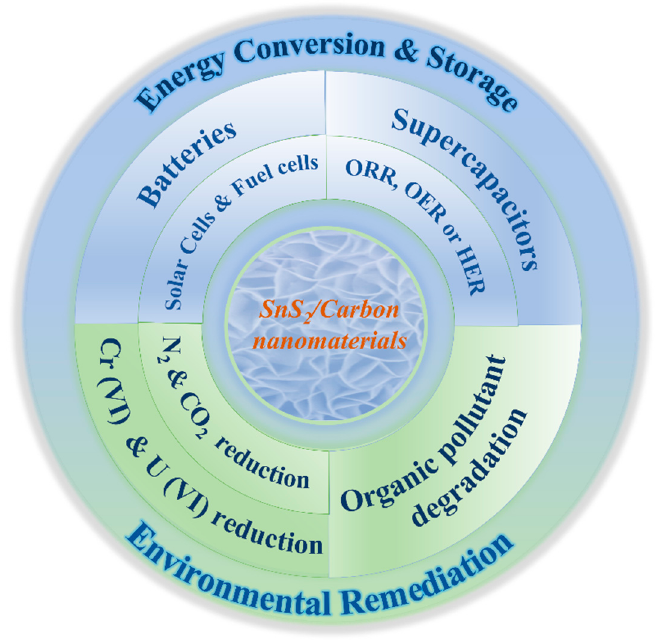
Figure 14. Applications of SnS 2 and SnS 2 /Carbon nanomaterials in environmental remediation, electrochemical energy conversion, and storage.